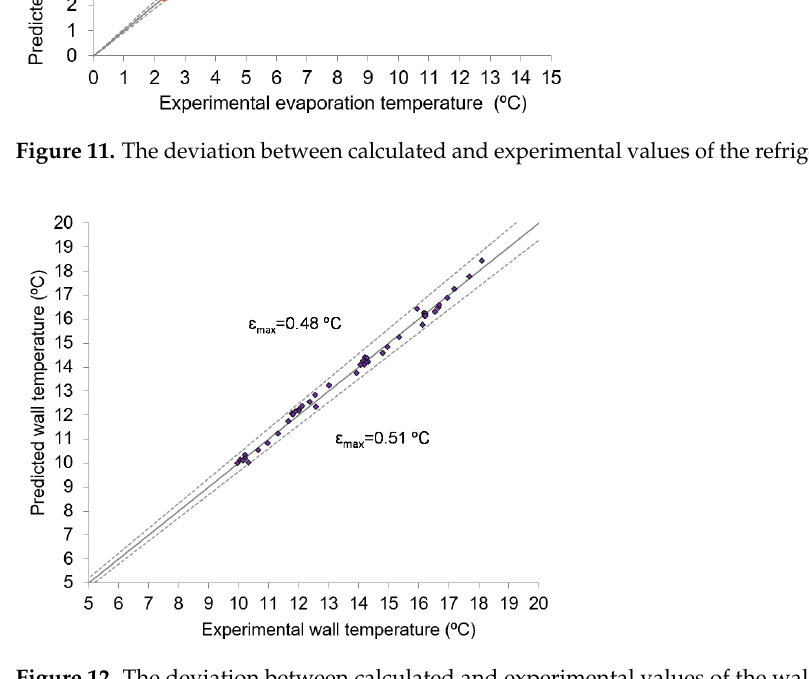
Figure 11. The deviation between calculated and experimental values of the refrigerant tempera- tures.